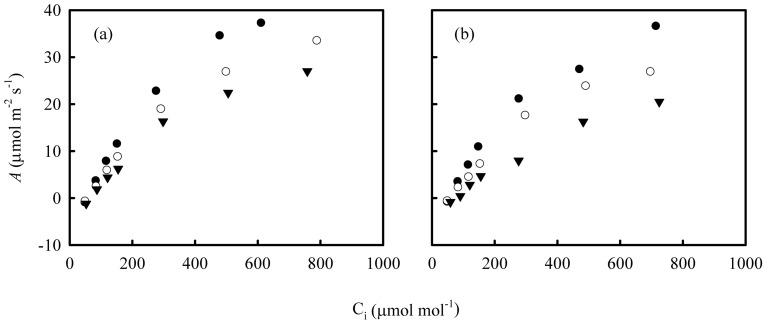

A/Ci response curves of newly expanded leaves in Shanyou 63 (a) and Yangdao 6 (b).The symbols of solid cycles, open cycles and solid triangles represent high, intermediate and low N supply, respectively.